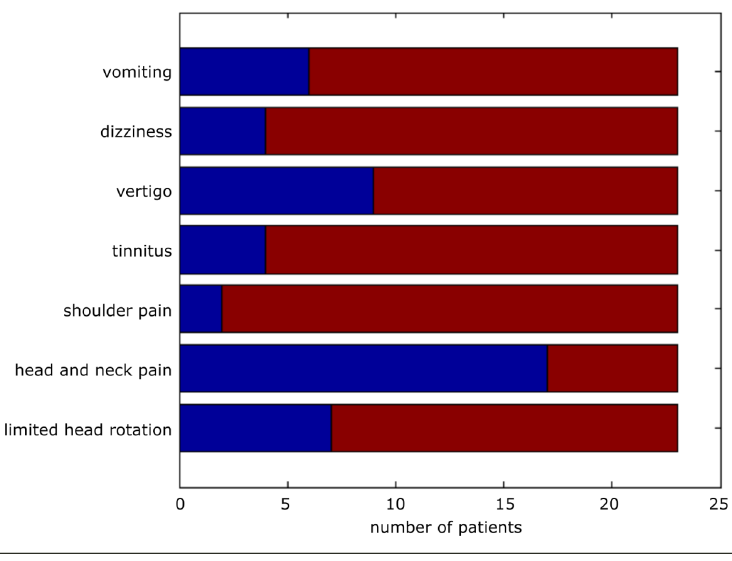
Each cell represents an average of the 23 muscle stiffness values of each subject. Muscle stiffness of each subject is the median of six repeated measurements of the average stiffness of an ROI (see the Methods section).